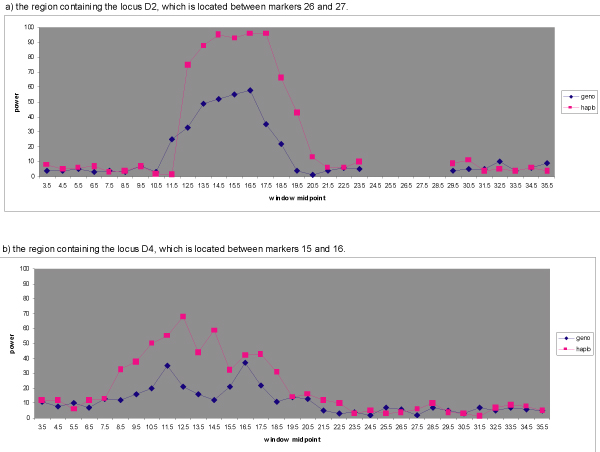
Power of methods for Loci D2 and D4. The power for each window is plotted at the midpoint of the window in terms of marker number within the region. The gap in the lines for D2 is for windows overlapping the end of the chromosome.